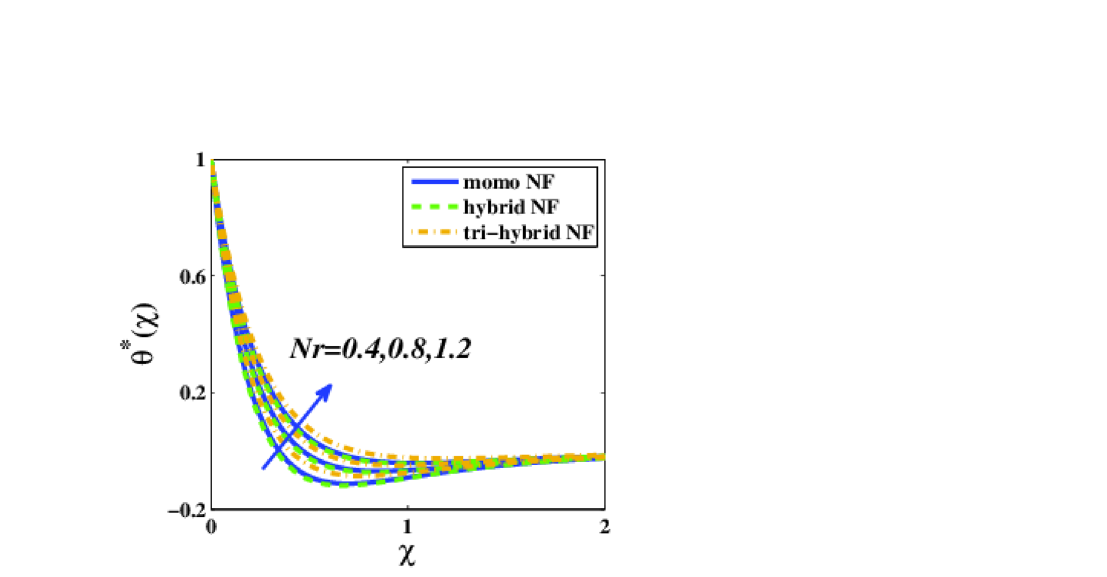
Figure 22. Result of Nr on θ ∗ (χ)